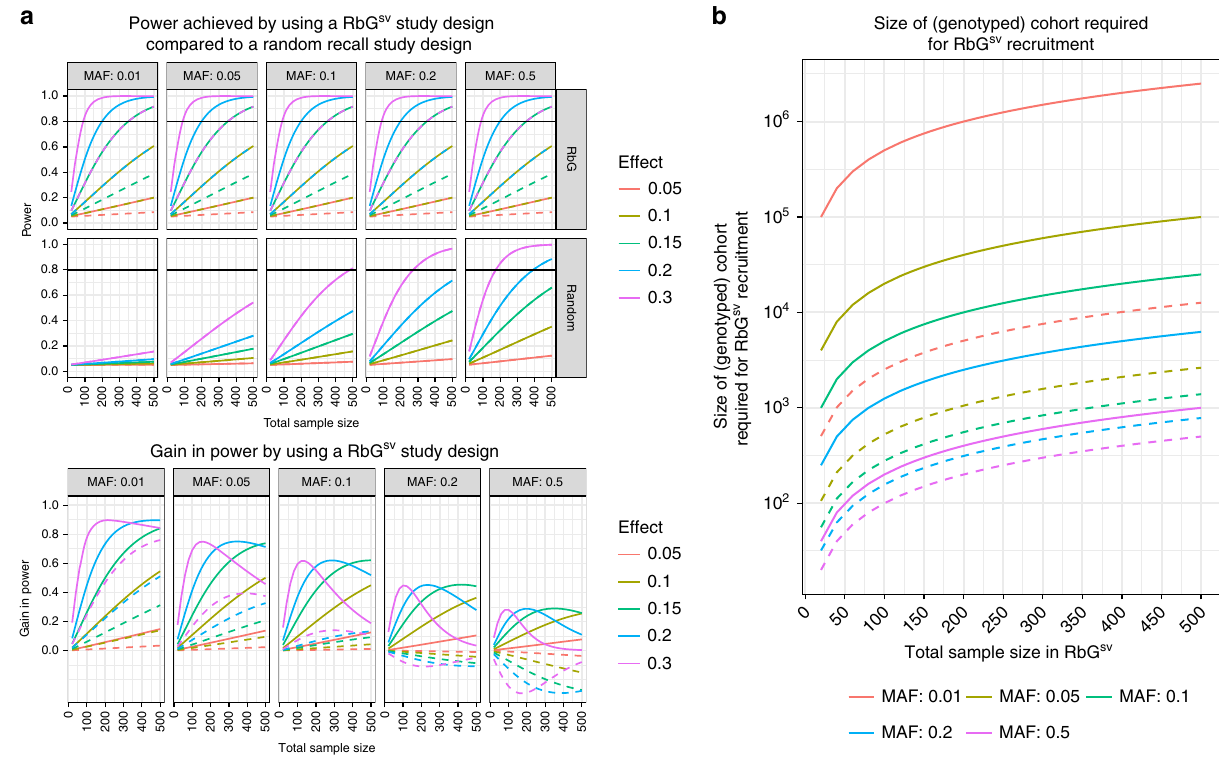
Fig. 3 Comparative power: RbG sv versus random recall study design. a Top panel: A comparison of power ( y -axis) achieved by an RbG sv study design versus a random sample selection design for a given minor allele frequency (MAF) and standardized per-allele effect size. The x -axis is the total sample size of the recall experiment. Solid lines represent the situation where an equal number of major and minor homozygotes are recruited. Dashed lines represent the situation where an equal number of major homozygotes and heterozygotes are recruited. Lower panel: A representation of the difference ( y - axis) between the power within an RbG sv study design and that from the equivalent random recall experiment. Solid lines represent the situation where an equal number of major and minor homozygotes are recruited. Dashed lines represent the situation where an equal number of major homozygotes and heterozygotes are recruited. b An illustration of the expected number of participants with genotypic data ( y -axis) needed in order to recruit suf fi cient minor homozygotes or heterozygotes for a given RbG sv study sample size ( x -axis) and minor allele frequency (MAF) (assuming HWE and a 100% participation rate). Solid lines represent the situation where an equal number of major and minor homozygotes are recruited. Dashed lines represent the situation where an equal number of major homozygotes and heterozygotes are recruited. For details of how the power calculations were carried out, see Supplementary Note 1. Here we assume a Type I error rate (alpha) of 0.05 and equal-sized genotype